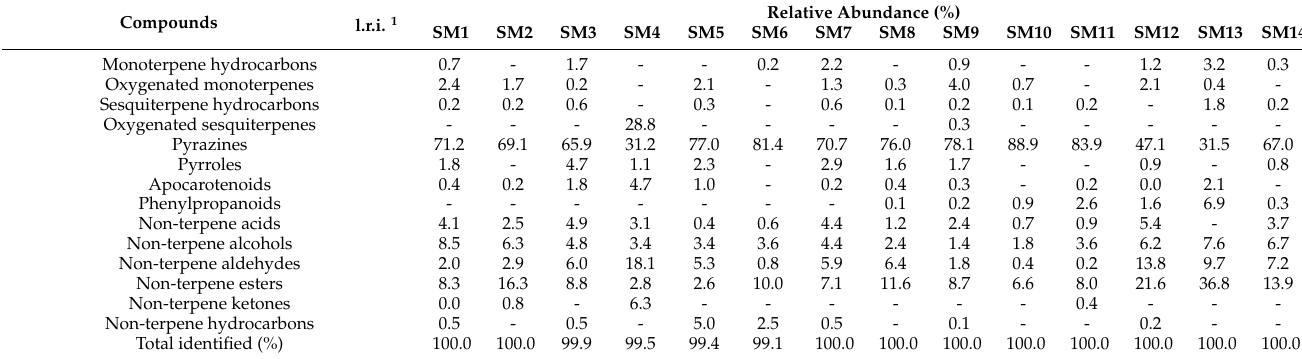
1 Linear retention indices on a DB5 capillary column. 2 Not detected. Legend of the sample names: the SM code stands for supermarket, followed by a unique number, each identifying one specific commercial sample among this